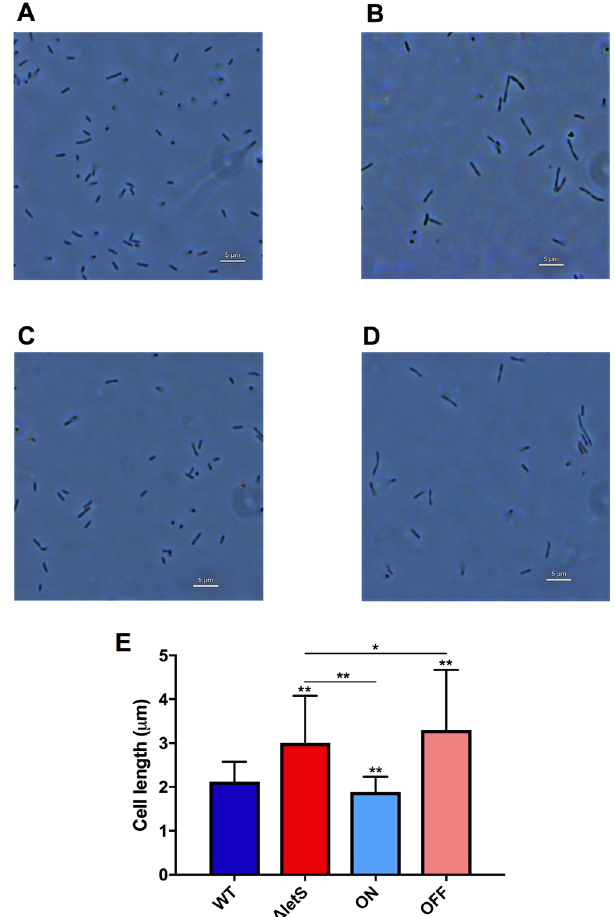
Figure 2. Deletion of letS affects the cell morphology of Lp in water. ( A ) Phase contrast microscopy was used to visualize morphological changes at 1000X magnification. A representative image of the WT ( A ), ∆ letS ( B ), ON ( C ) and OFF ( D ) exposed to water for 24 hours are shown. In Panel E, Image J software was used to quantify the average length of 100 cells after exposure to water for 24 hours. The scale bar is equivalent to 5 μ m. An unpaired, one-tailed Student’s t-test was used to assess statistical significance versus the WT, unless identified otherwise. * p < 0.05; ** p < 0.0005.